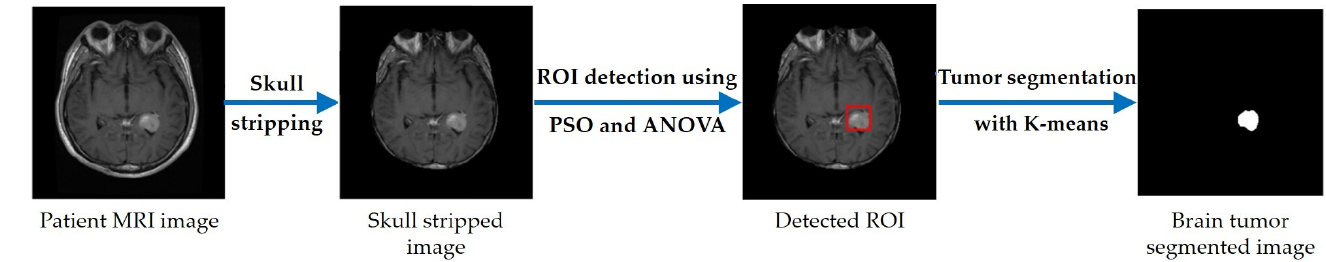
Figure 8. Flowchart of the proposed segmentation method.